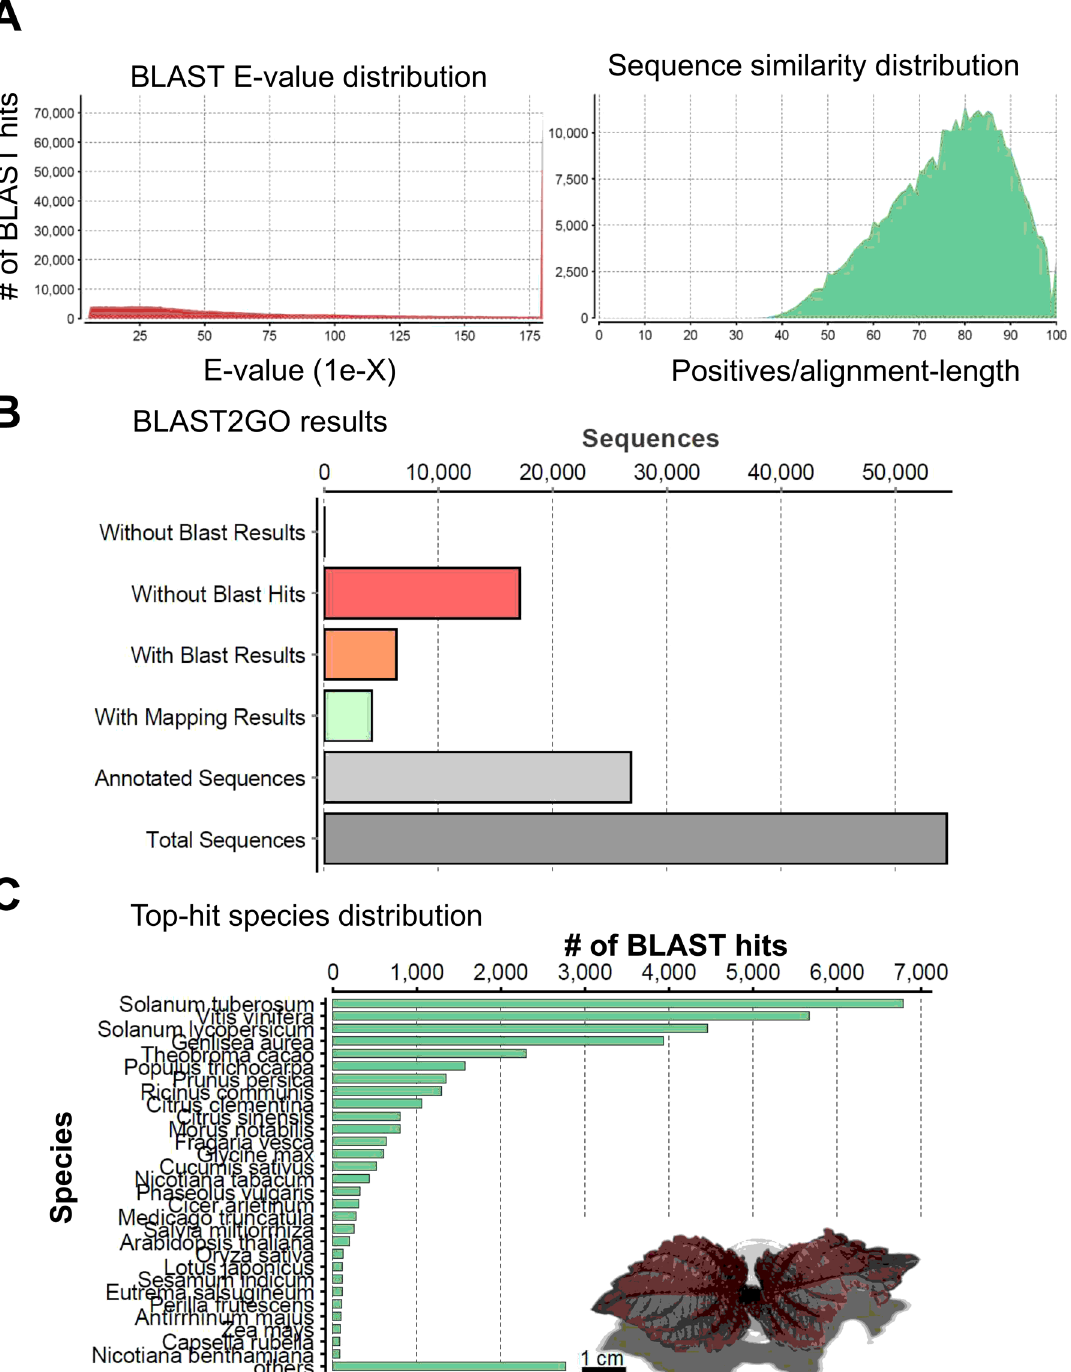
Fig 2. Characterization of the assembled unigenes based on a non-redundant (NR) protein database search in red perilla. (A) (Left panel): E-value distribution of BLAST hits for the assembled unigenes with a cutoff of E-value < 10 − 5 . (Right panel): Similarity score distribution of the top BLAST hits for the assembled unigenes with a cutoff of E-value < 10 − 5 . (B) Bar chart of the data distribution from BLAST2GO [37]. (C) Species distribution of the top BLAST hits for the assembled unigenes with a cutoff of E-value < 10 − 5 .